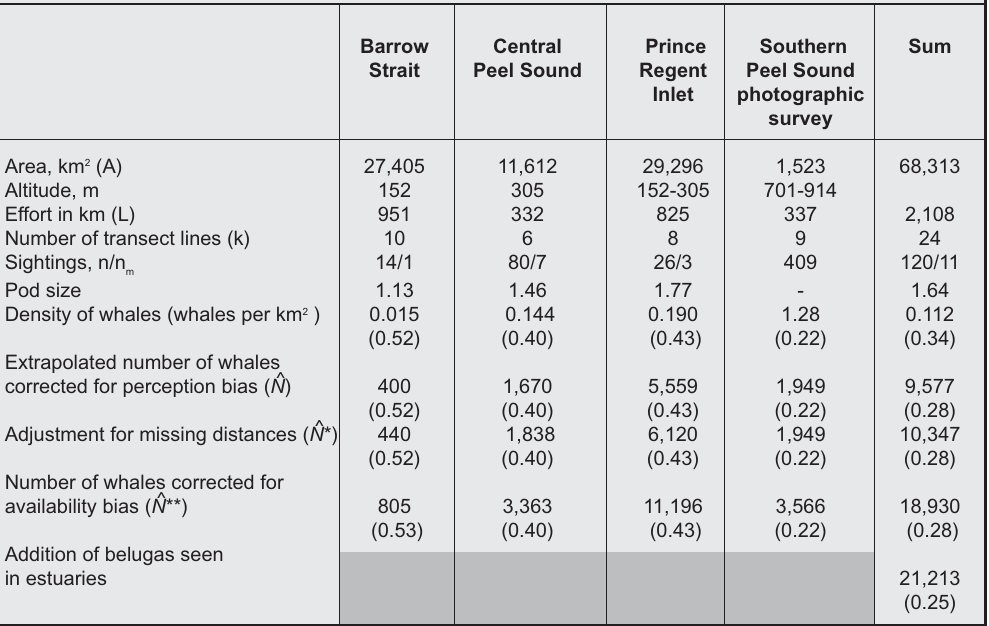
). The corrected number of m